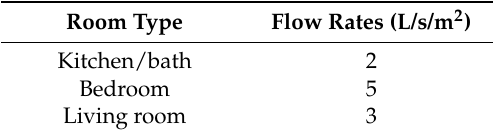
Table 3. The flow rates were chosen following the recommendations given by Spanish regulation. Table 3. Flow rates of each fan corresponding to a specific room